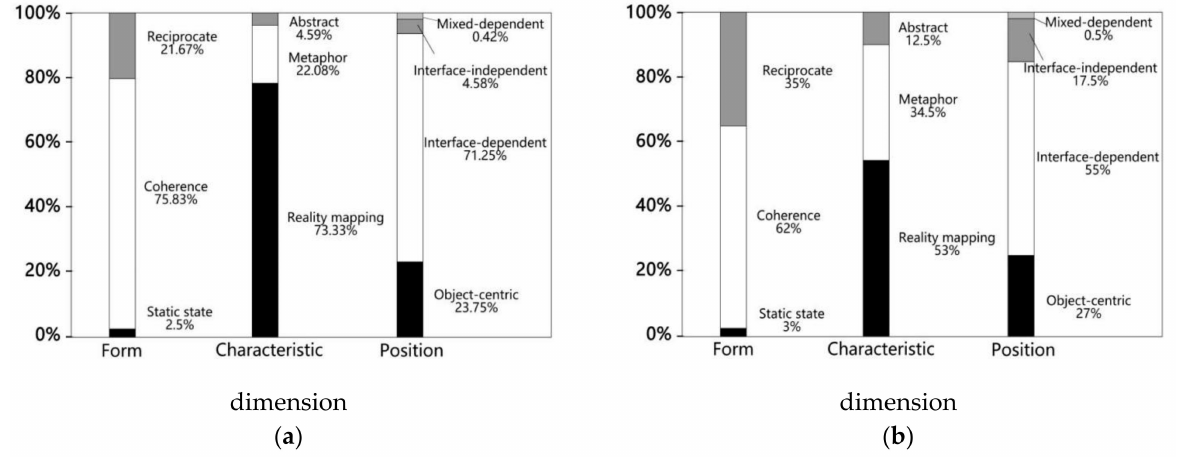
Figure 4. ( a ) Percentage of actions of young group in three dimensions (form, characteristics and position); ( b ) percentage of actions of elderly group in three dimensions (form, characteristics and position).